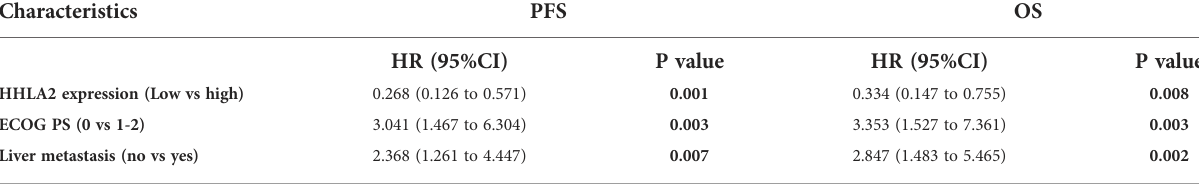
Table 4 Multivariate analyses of prognostic factors correlated with PFS and OS.